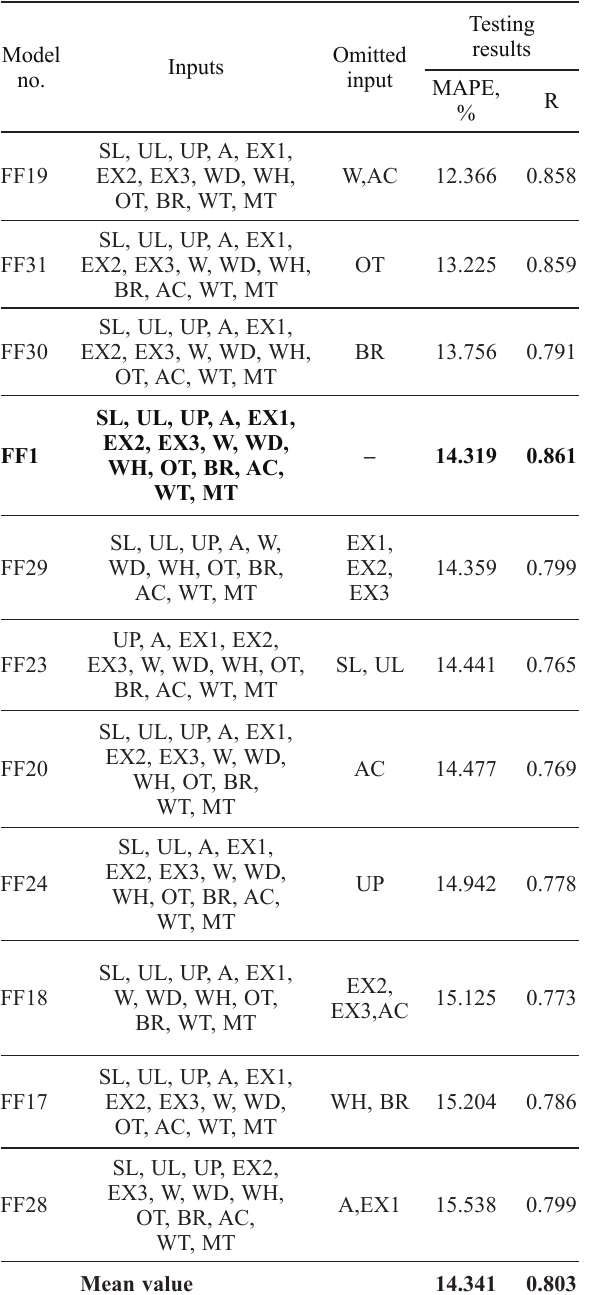
Table 2. Productivity modeling results for FFNN Model no.